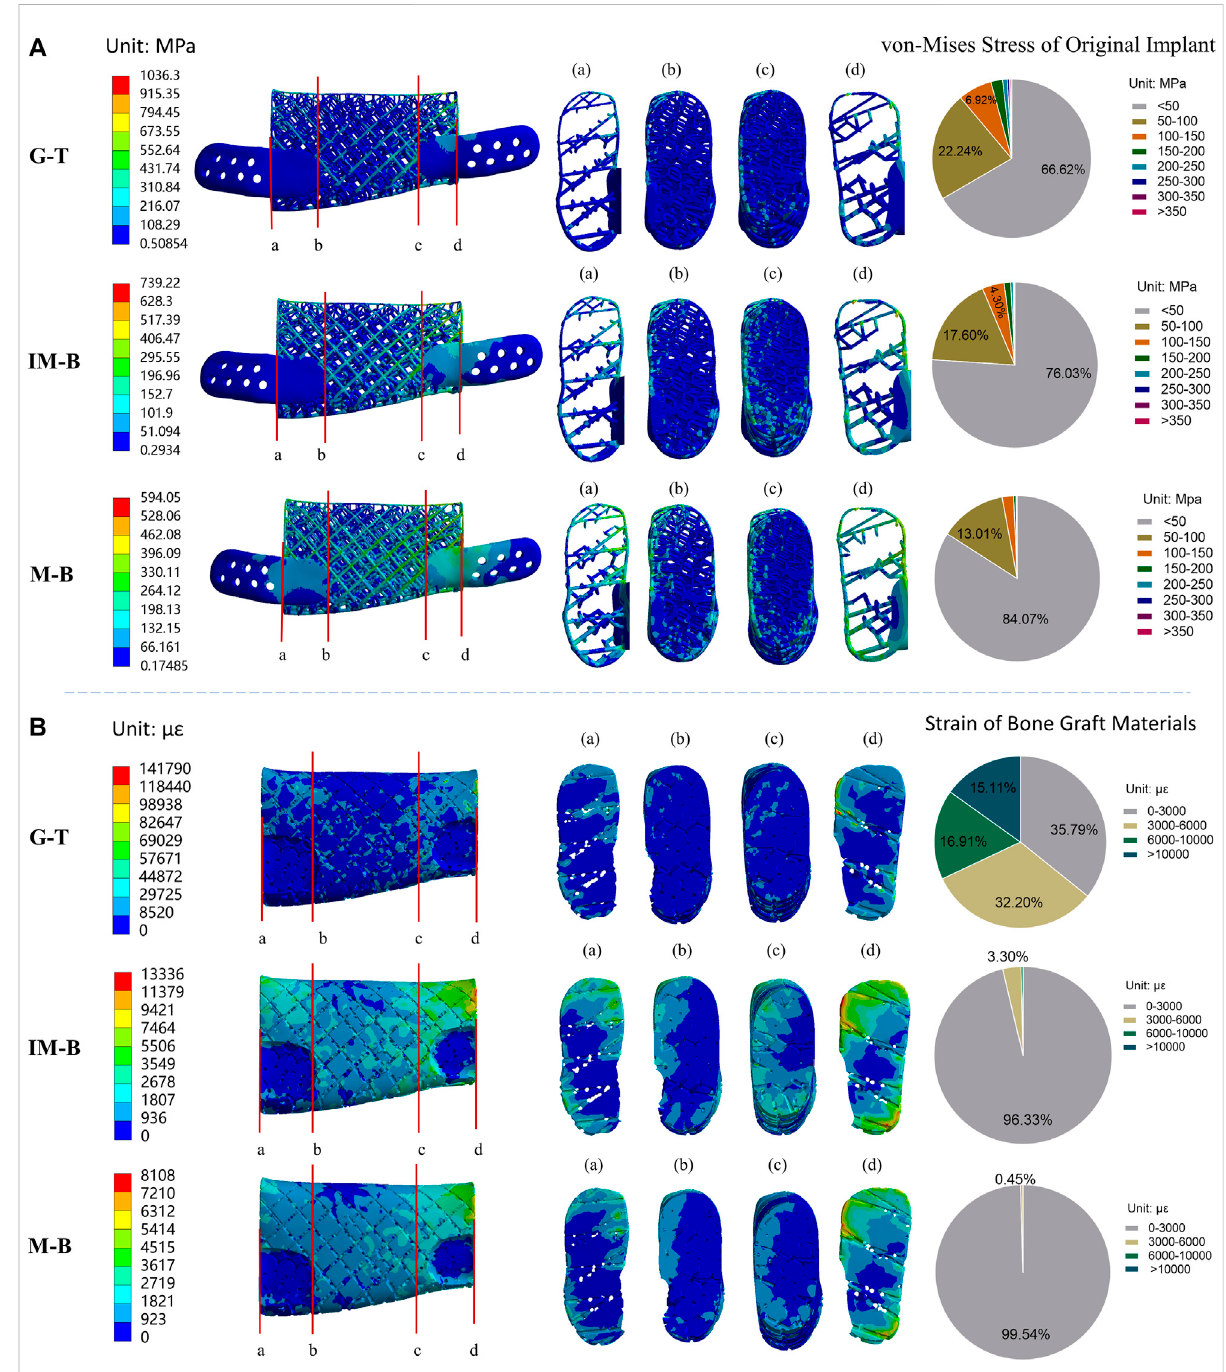
FIGURE 5 Von-Mises stress of original lattice-like implant and strain of bone graft materials in different periods. Granulation tissue (G-T) representing the early stages, Immature bone (IM-B) representing the middle period and mature bone (M-B) representing the fi nal period. (A) The von-Mises stress of originalimplantindifferentperiods. (B) Thestrainofbonegraftmaterialsindifferentperiods. (a – d) illustratedfoursectionsofvon-Misesstress/strain for the original implant/bone graft materials. The pie charts show the frequency of von-Mises stress/strain for the original implant/bone graft materials in different